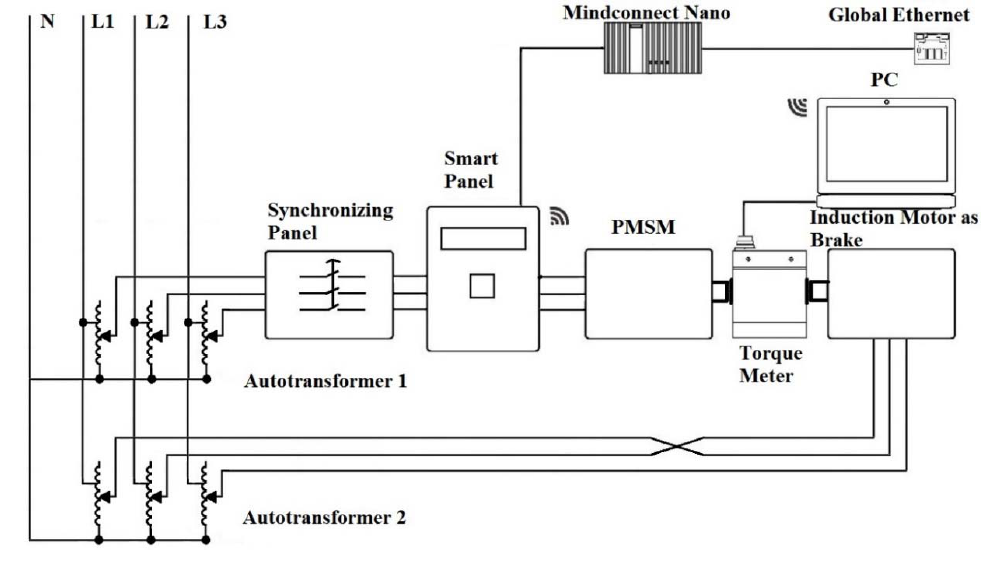
Figure 4. Circuit diagram of the test bench.